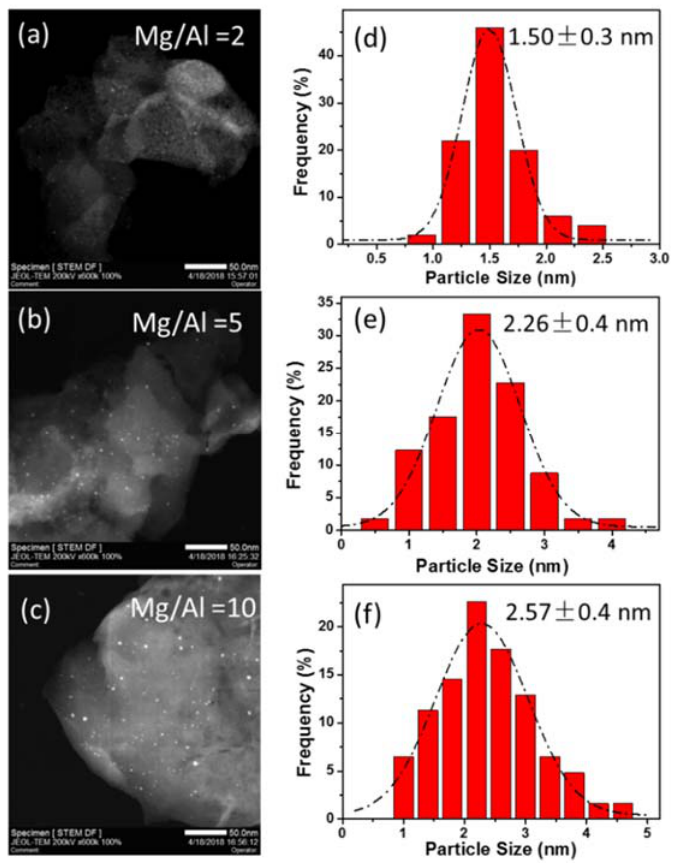
Figure 5. ( a – c ) High-angle annular dark-field scanning transmission electron microscopy (HAADF-STEM) images, and ( d – f ) size distribution of metal PtSn/Mg(Al)O particles with different Mg:Al ratios.